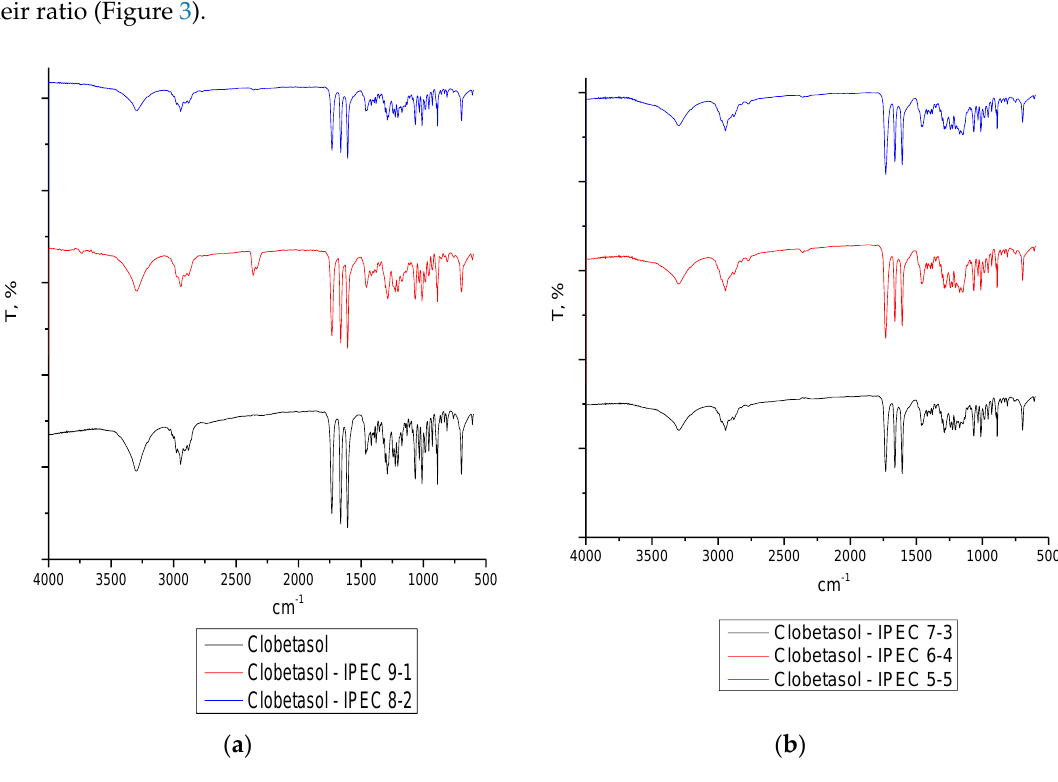
Figure 3. ATR-FTIR-spectra of raw material CP (panel ( a )) and CP loaded IPECs in the following ratio: (panel ( a )) 9:1, 8:2; (panel ( b )) 7:3, 6:4, 5:5.